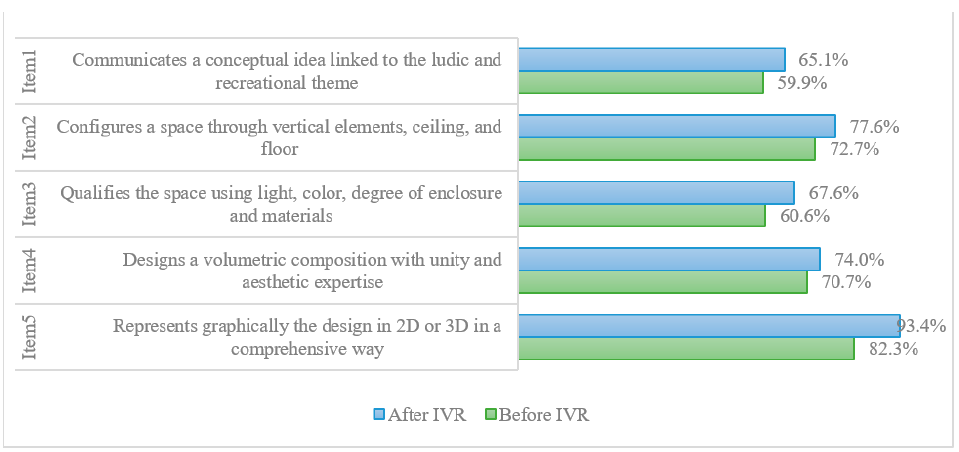
Figure 12. The qualifications of the five items before and after the use of IVR in design.